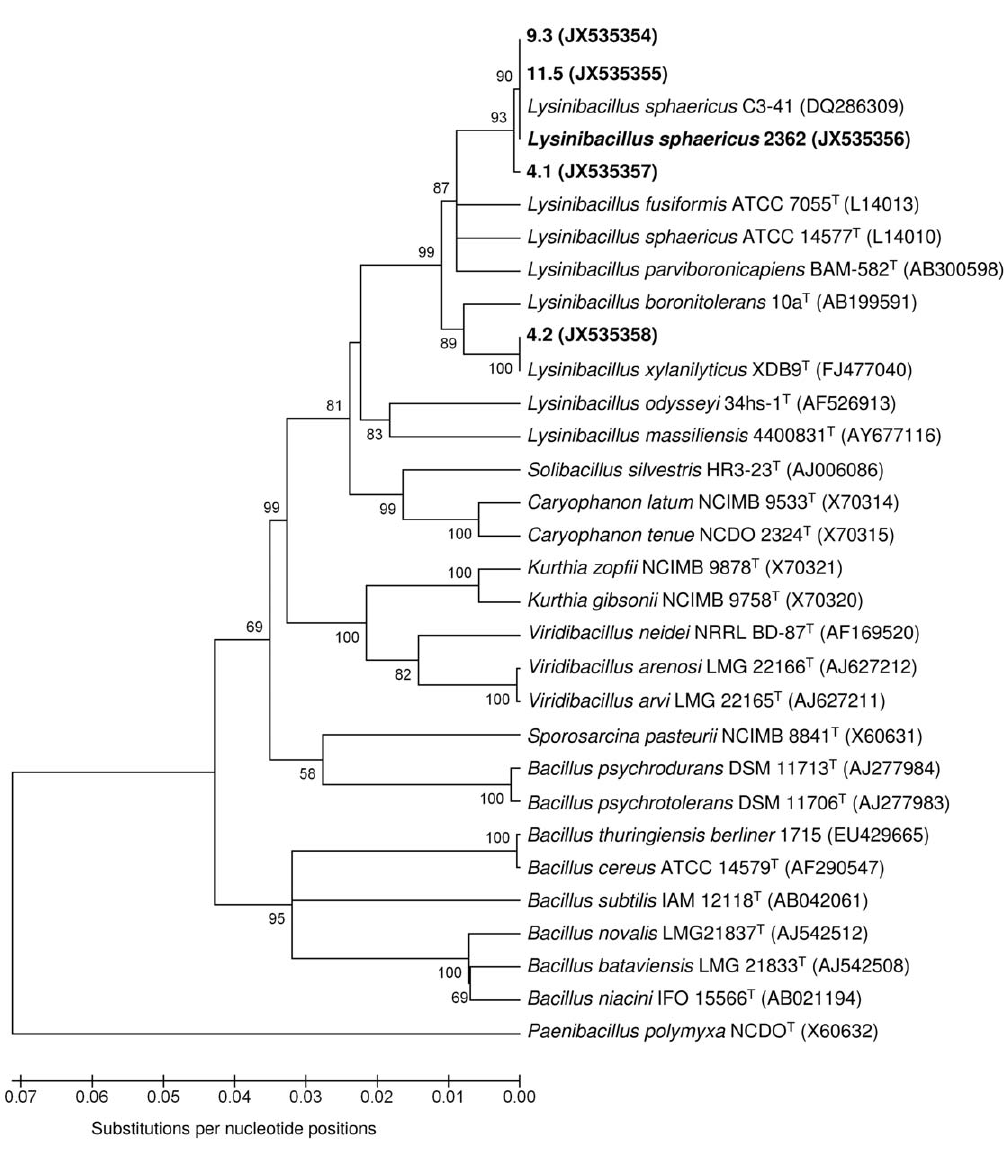
Figure 4. Neighbour-joining phylogenetic tree based on 16S rRNA gene sequences of isolates 4.1, 4.2, 9.3 and 11.5, as well as strain 2362 and some other strains belonging to related taxa. The evolutionary distances are based on the Kimura 2-parameter model. Bootstrap values ( . 50%) based on 1000 replications are shown at branch nodes. Gene Bank accession numbers are given in parentheses. Paenibacillus polymyxa NCDO 1774 T was used as outgroup. Phylogenetic analysis was performed using MEGA version